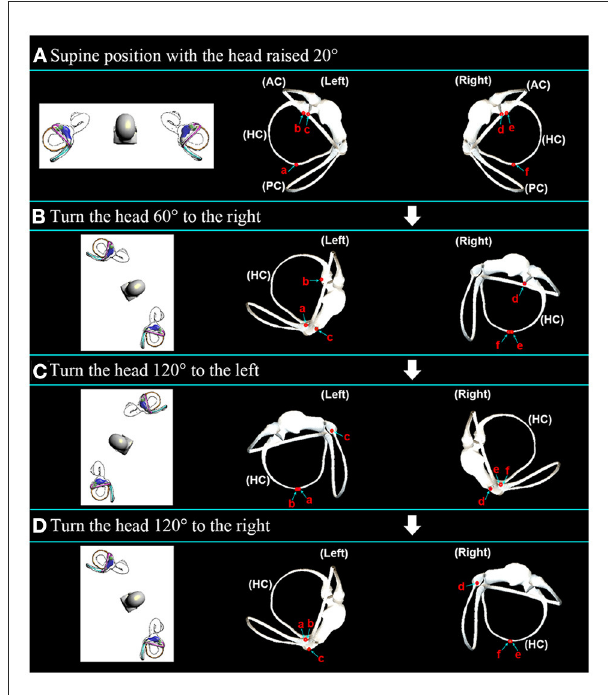
FIGURE6 The movement of the otoliths in the horizontal semicircular canal during the 60 ◦ roll test. (A) The stable position of the otoliths in the supine position with the head elevated 20 ◦ . (B) The stable position of the otoliths after 60 ◦ right rotation. (C) The stable position of the otoliths after turning 120 ◦ to the left. (D) The stable position of the otoliths after 120 ◦ right rotation.